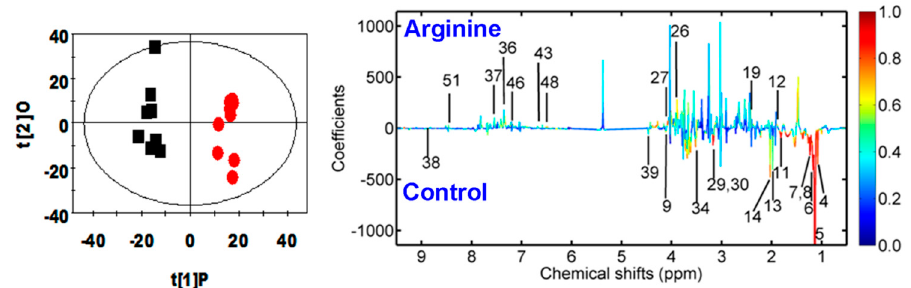
Figure 3. OPLS-DA scores plots ( left panel) and the corresponding coefficient loading plots ( right panel) obtained from the 1 H-NMR spectra of 24 h urine samples from the control (black squares) and arginine (red circles) groups ( R 2 X = 0.312, Q 2 = 0.529). Two samples from the control group were excluded because they were outside the Hotelling’s T 2 ellipse on the score plot. A color scale in the coefficient plot demonstrates the significance of metabolite variation between the arginine and control groups. Table 3. OPLS-DA coefficients obtained from the NMR data of urine metabolites derived from the (A) control and (B) arginine groups.